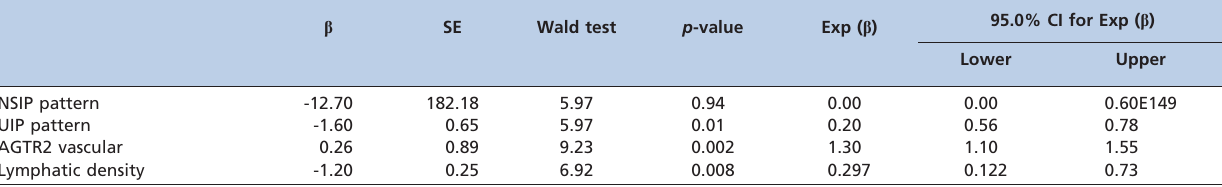
Table 3 - Cox proportional hazards regression to ascertain the individual contribution of the histological patterns (NSIP and UIP) and the morphological factors associated with survival and to compare the adjusted survival between the groups (-2 log-likelihood = 59.93; Chi-squared = 40.10; p ,